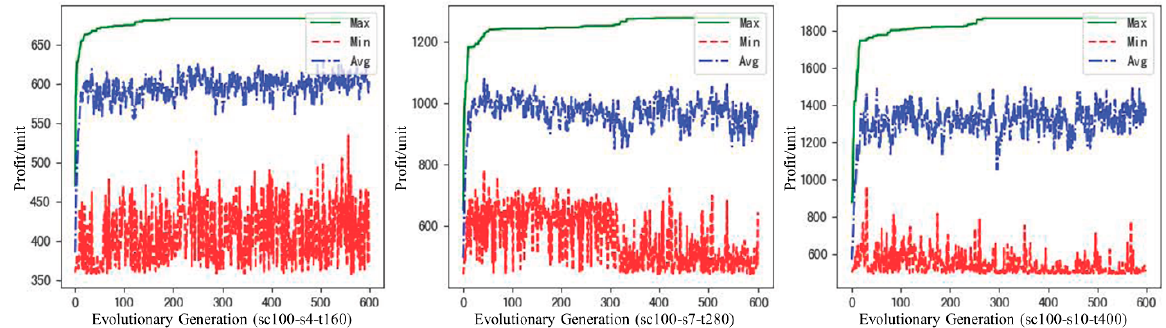
Figure 8. The GEP evolutionary process.